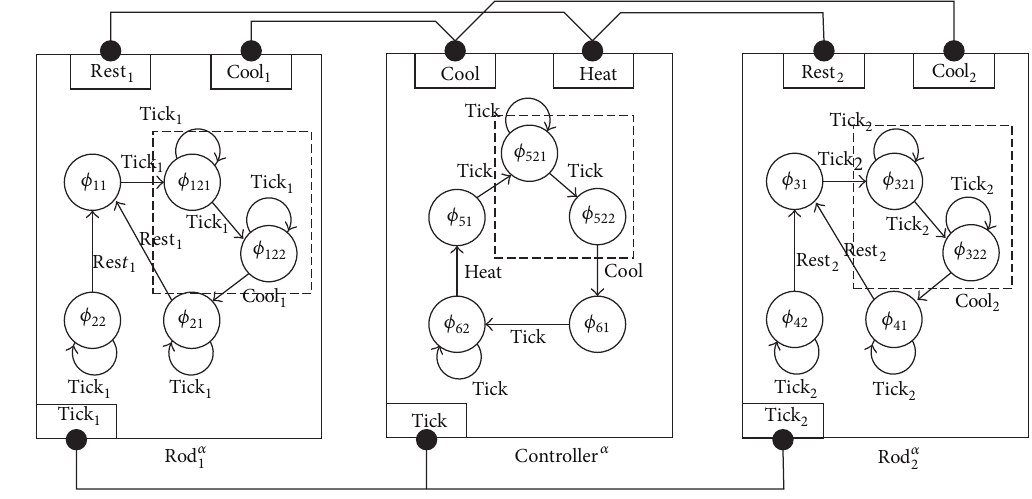
Figure 6: The refined abstract